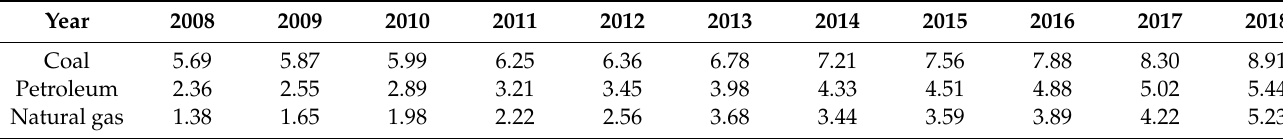
Table 6. CO 2 emissions of di ff erent technologies (10 8